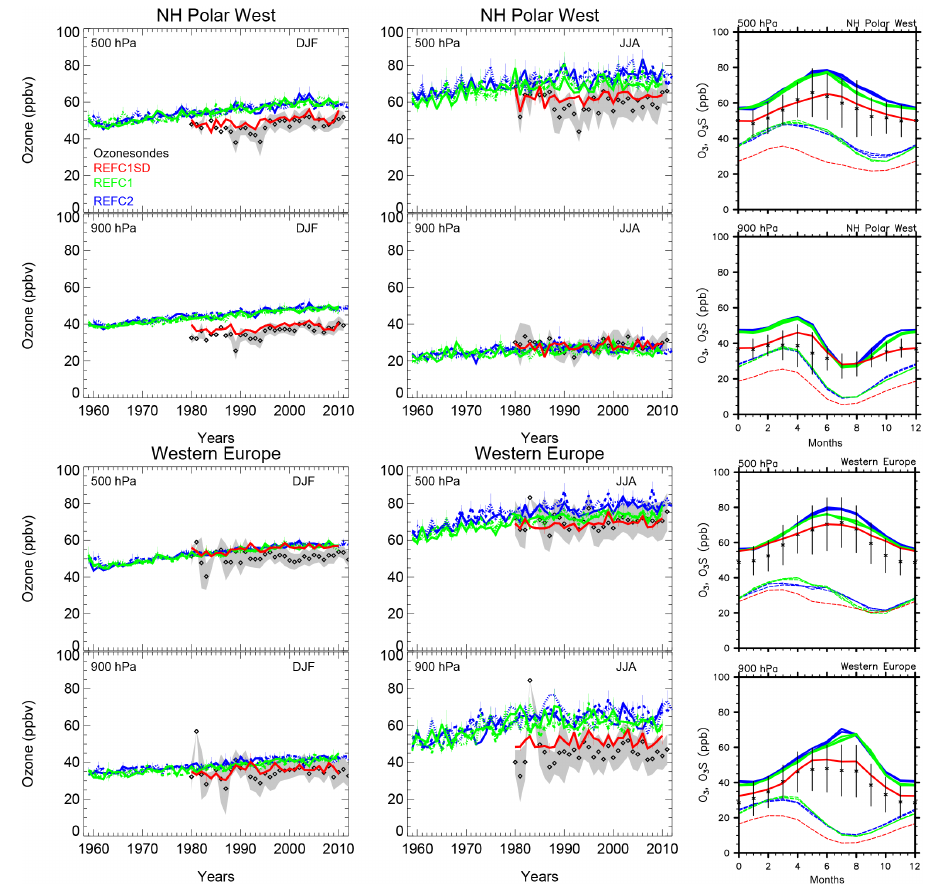
Figure 3. Left and middle column: time evolution of seasonal averaged and regionally aggregated ozone mixing ratios derived from ozone soundings (black diamonds) and model results (colored lines) at two different pressure levels, two different seasons (DJF: left, JJA: right) and regions (NH polar west, and western Europe). Grey shading indicates the standard deviation of the observations that include at least 12 observed profiles per season in a year. Colored error bars indicate the standard deviation based on monthly averaged model output. Right column: Regionally aggregated seasonal cycle comparisons of ozone soundings (black lines) and model simulations (colored lines), averaged between 1995 and 2010. Dashed lines indicate mixing ratios of the stratospheric ozone tracer (see text for more